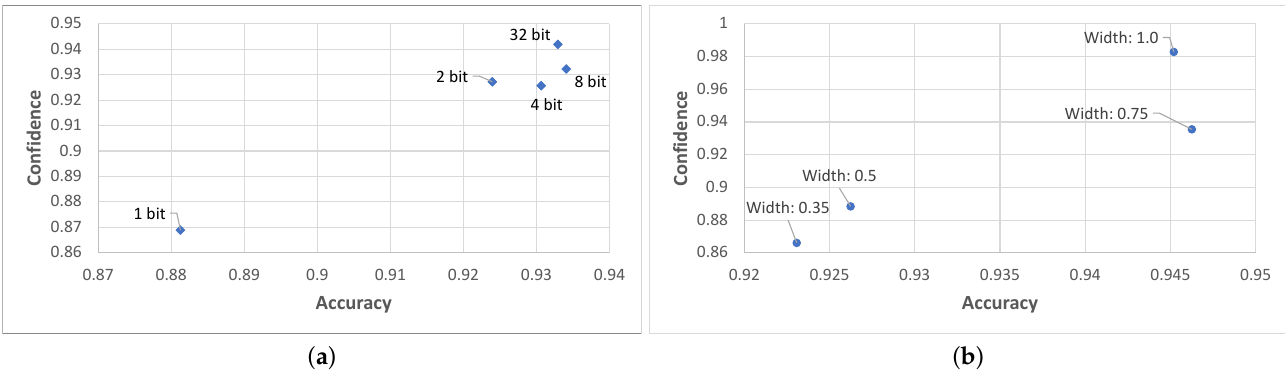
Figure 6. Comparison of the neural network accuracy and its softmax-based confidence for different compression levels on the UCI HAR dataset. ( a ) Any-Precision. ( b ) SNN (Slimmable Neural